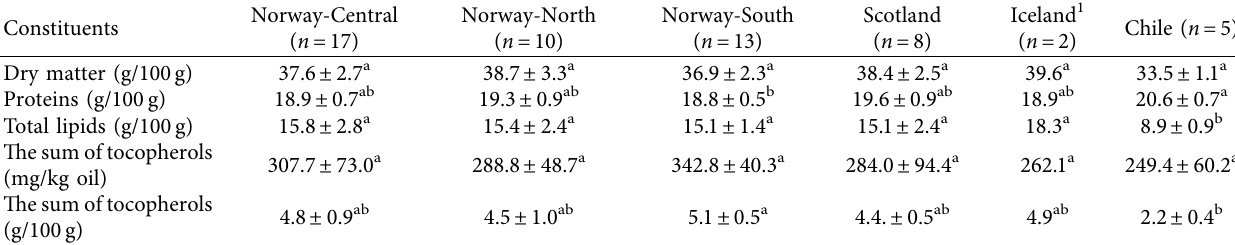
Table 1: Dry matter, proteins, total lipids, and sum of tocopherols determined in Atlantic salmon from different origins. Constituents